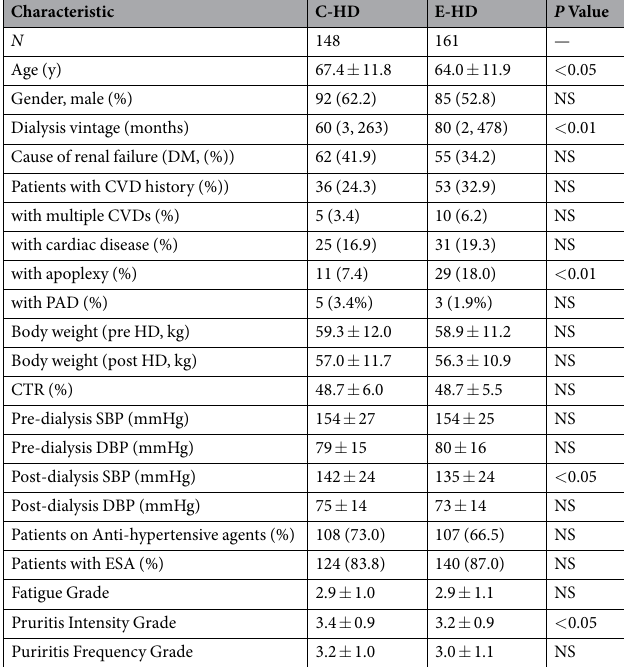
Table 1. Patient characteristics. C-HD, conventional haemodialysis; E-HD, electrolyzed water haemodialysis. CVD, cardio-cerebrovascular disease; HD, haemodialysis; PAD, peripheral arterial disease; SBP, systolic blood pressure; DBP, diastolic blood pressure; ESA, erythropoiesis stimulating